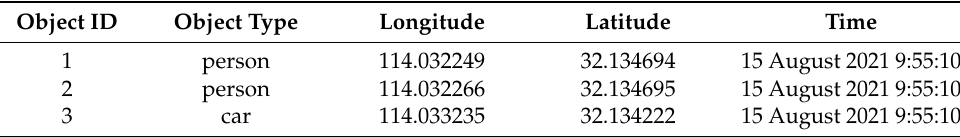
Table 1. The real-time object stream data.